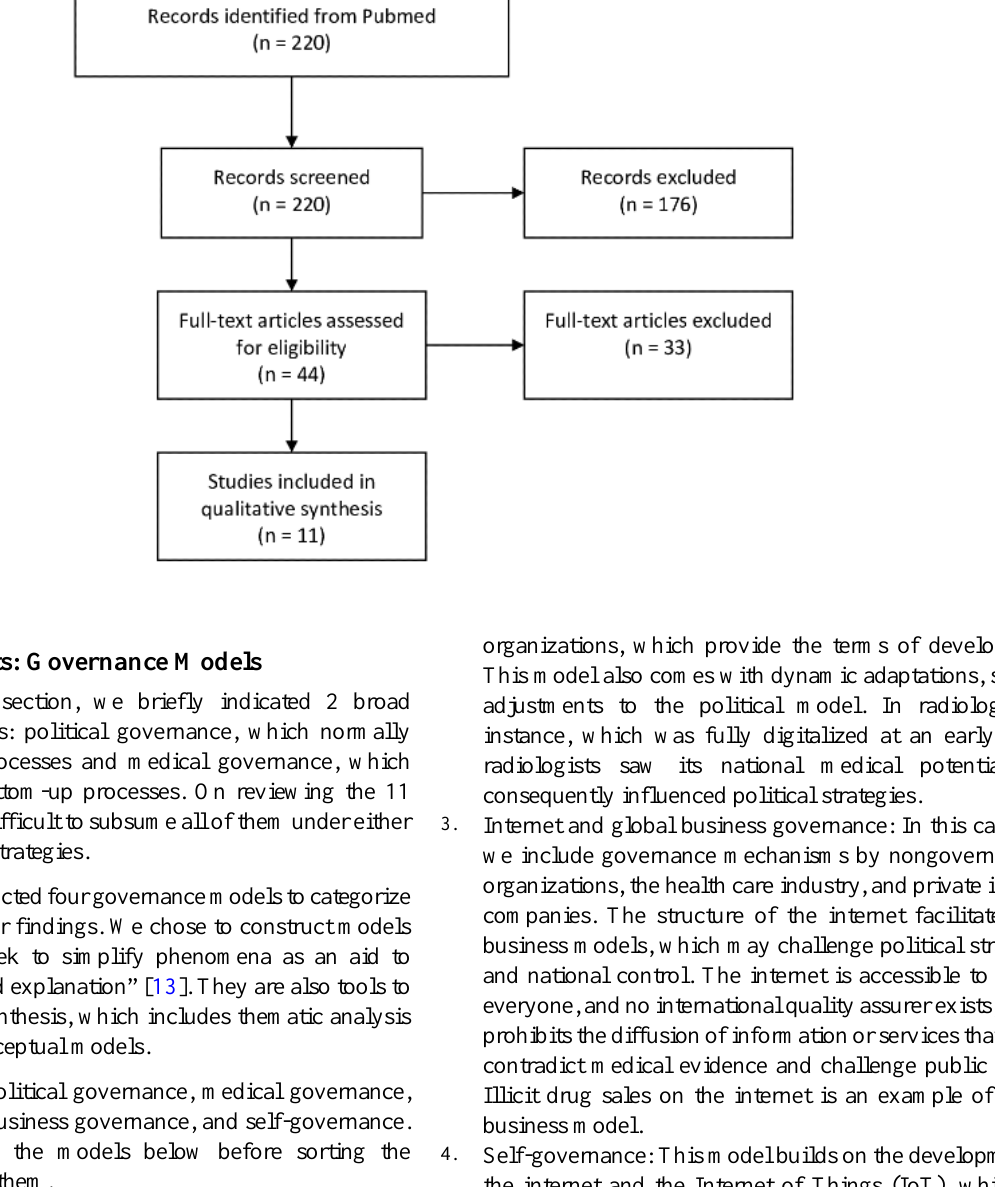
Figure 1. PRISMA (Preferred Reporting Items for Systematic Reviews and Meta-Analyses)